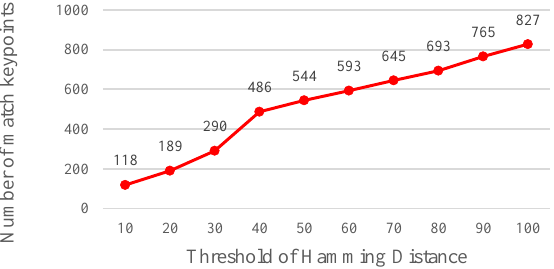
Figure 14. Relationship between the Hamming distance threshold value and number of matched keypoints.